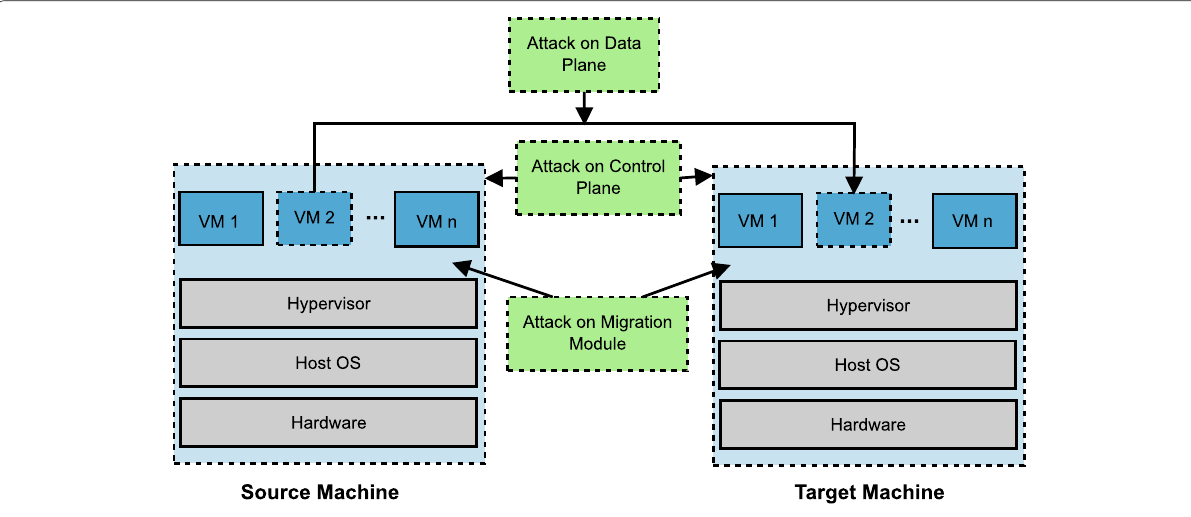
Fig. 10 Possible attacks during live VM